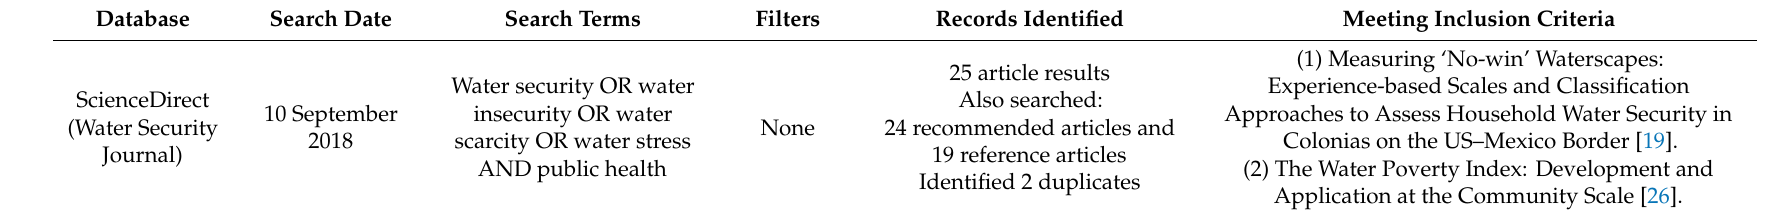
Table A1. Search Strategy for One Database.